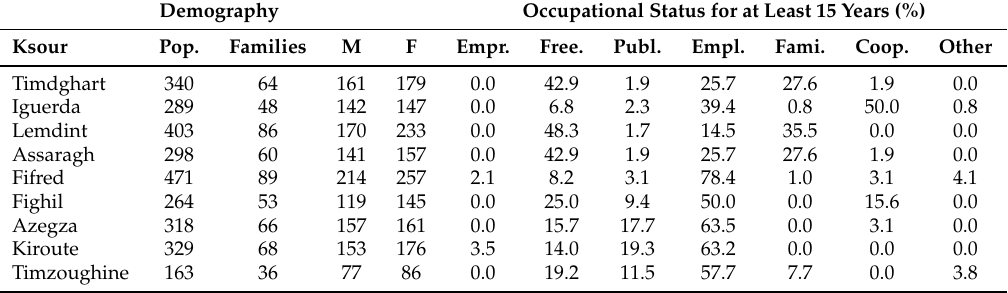
Table A1. Census and occupational data of the population living along the assif Aguinane. Ksours are listed from upstream to downstream. The occupational status can be: employer, freelancer (in majority farmers), employee in public sector, employee in private sector, familiar care, member of a cooperative and other